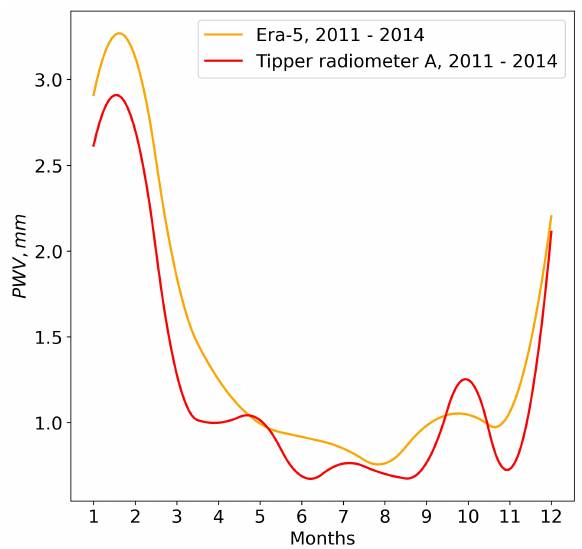
Figure 4. Changes in mean monthly PWV values estimated from Era-5 reanalysis data and changes in mean monthly measured PWV values within the Chajnantor